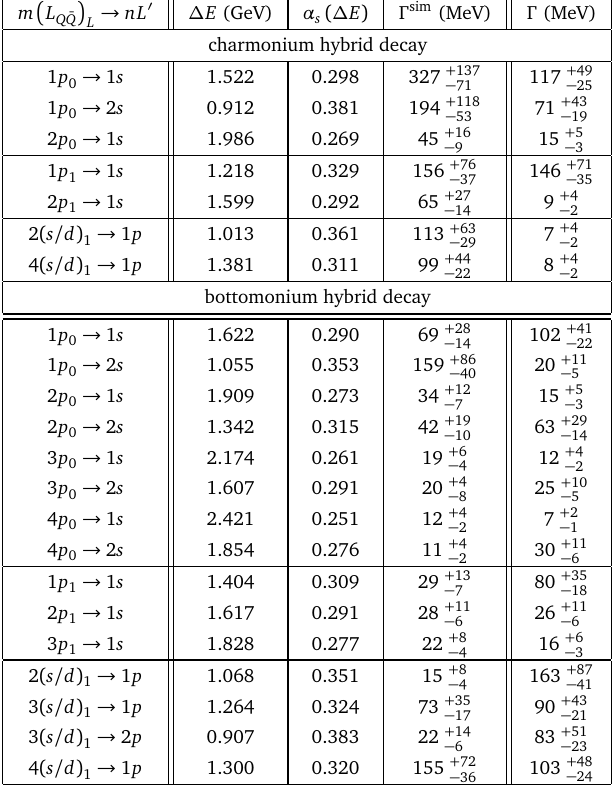
Table 1: Preliminary results for the spin-conserving inclusive decay rate for hybrids → Q + X due to r · E vertex in Eq. (13). The hybrid decays to quarkonium states: H m n (cid:0) (cid:1) L whereas the quarkonium states are denoted by nL (cid:48) . states are denoted by m Q ¯ Q L The decay rate in fourth column is computed using Eq. (20) and in last column using ( ∆ E ) are obtained using the RUNDEC code [ 25 ] . The Eq. (17). The values of α s upper error bar is from changing the scale to ∆ E / 2 in α while the lower error bar s is from changing the scale to 2 ∆ E in α s